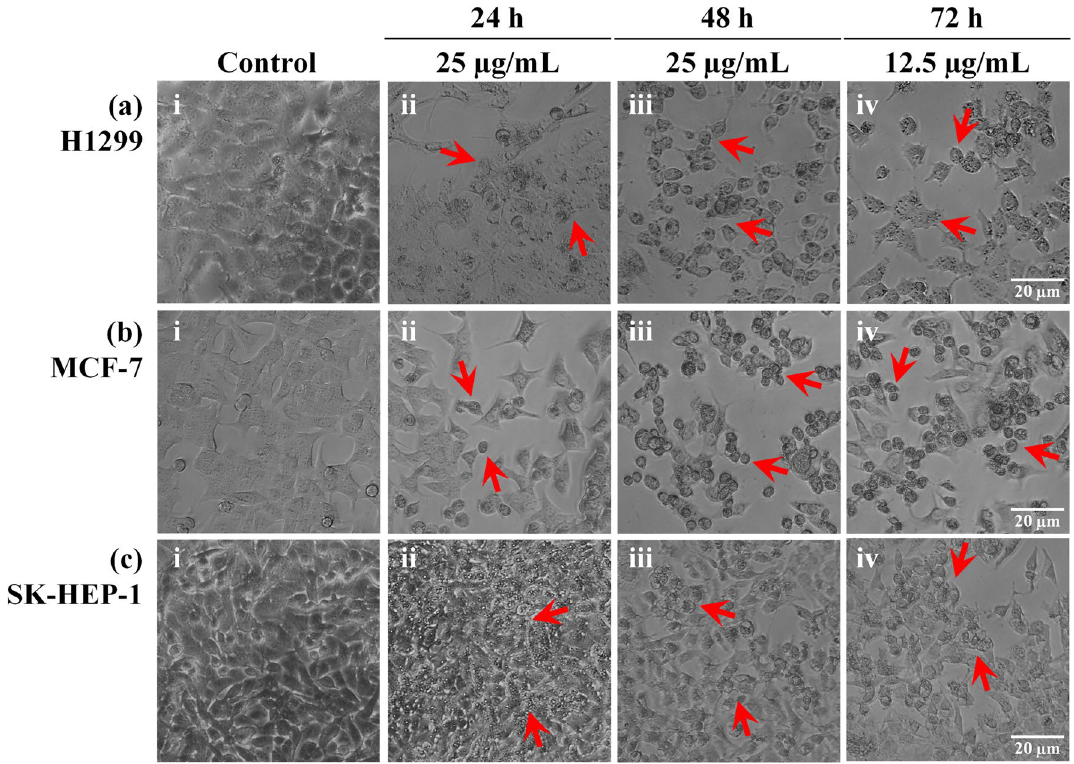
Figure 3. Light microscopy observation of morphological changes, indicated by red arrows, in H1299 ( a ), MCF-7 ( b ), and SK-HEP-1 ( c ) cells treated with 12.5 µg/mL (iv) and 25 µg/mL (ii and iii) of R-S5-C1-H1 for